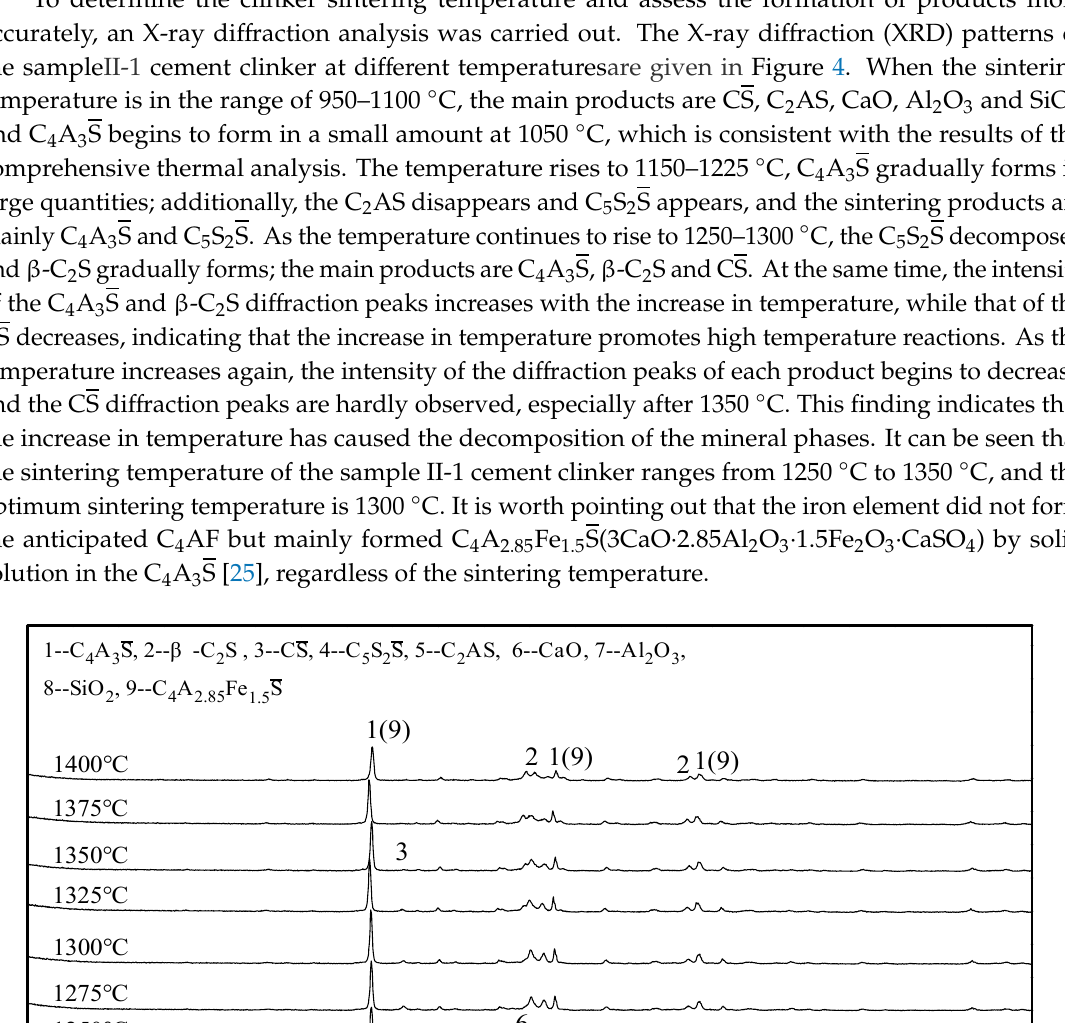
Figure 3. Comprehensive thermal analysis (DSC-TG) curves of the raw materials: ( a ) petroleum coke desulfurization slag; ( b ) fly ash; ( c ) carbide slag; ( d ) bauxite.